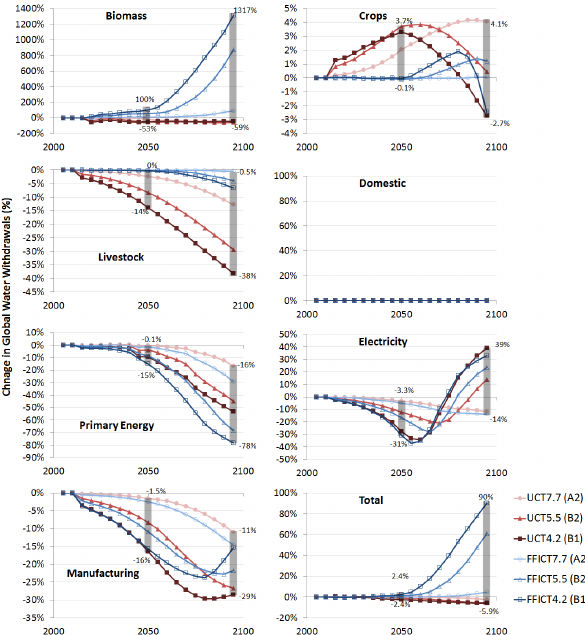
Figure 9: Deviations in GCAM’s estimates of global water withdrawals from the baseline (A1fi) scenario (no climate policy) for each of the six climate change mitigation policy scenarios (UCT7.7 (A2), UCT5.5 (B2), UCT4.2 (B1), FFICT7.7 (A2), FFICT5.5 (B2), FFICT4.2 (B1)) for each of the water demand sectors.